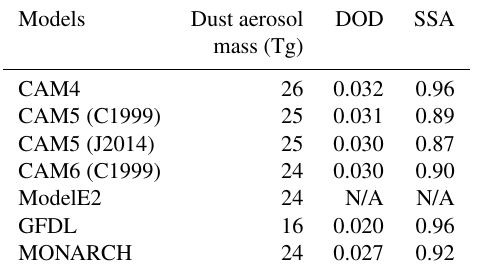
MONARCH 24 0.027 0.92 N/A – no